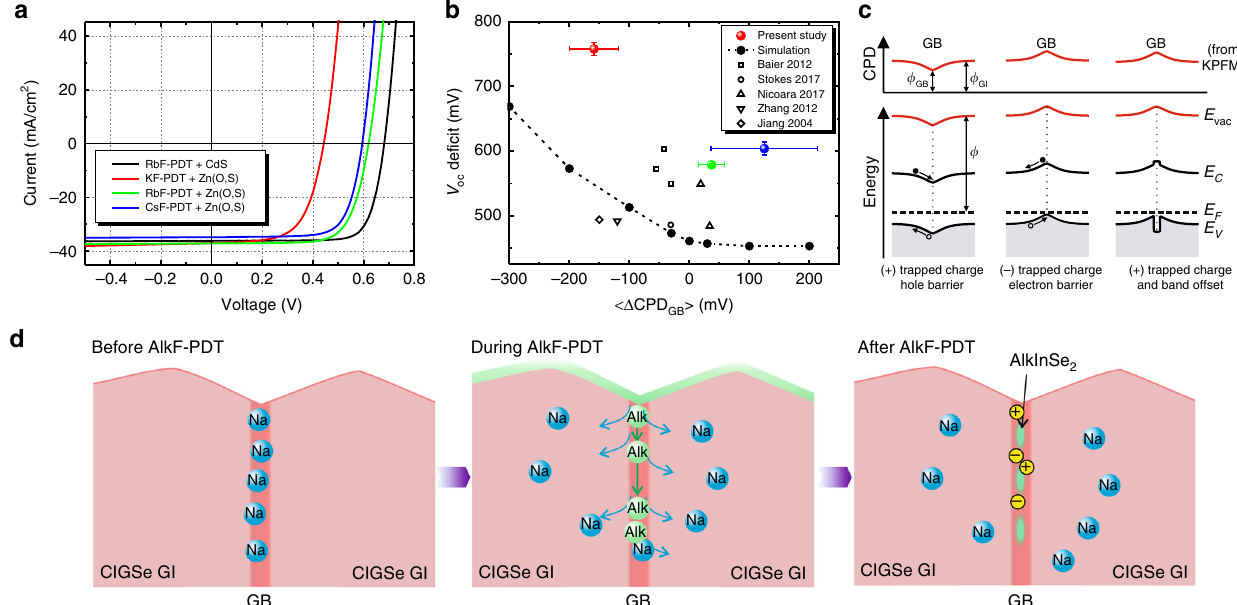
Fig. 5 Role of grain boundaries in solar cell devices. a J – V characteristics of reference solar cells for the CIGSe layers with different AlkF-PDT. b Open- circuit voltage de fi cit with respect to the respective band gap as a function of the potential change at the GBs for the three studied samples (large colored circles) and for some results taken from the literature 16,20,21,55,63 . The black dashed curve shows the results obtained from our simulations. c Schematic band diagrams (lower panels) and expected CPD as measured by KPFM (upper panels) for a GB with a hole barrier (left), an electron barrier (middle) and an electron barrier with a band offset (right). d Schematic of the PDT process illustrating the displacement of Na to the grain interior by the heavier alkali- elements used in the PDT and the possible formation of secondary phases and charged defects at the